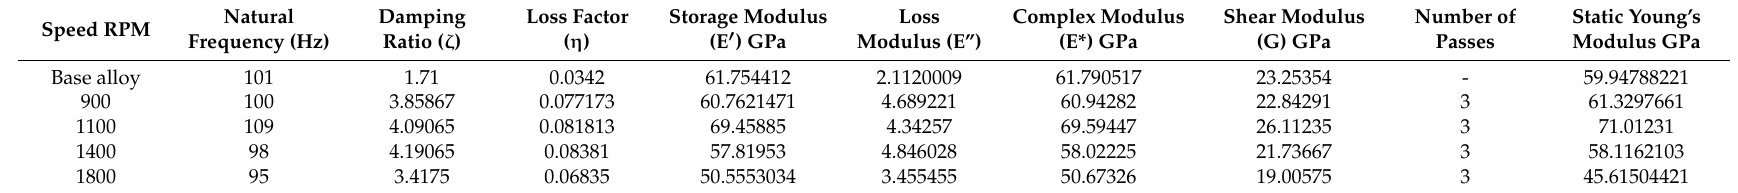
Table 2. Dynamic properties of the investigated surface composite beam at a constant processing parameter travel speed of 10